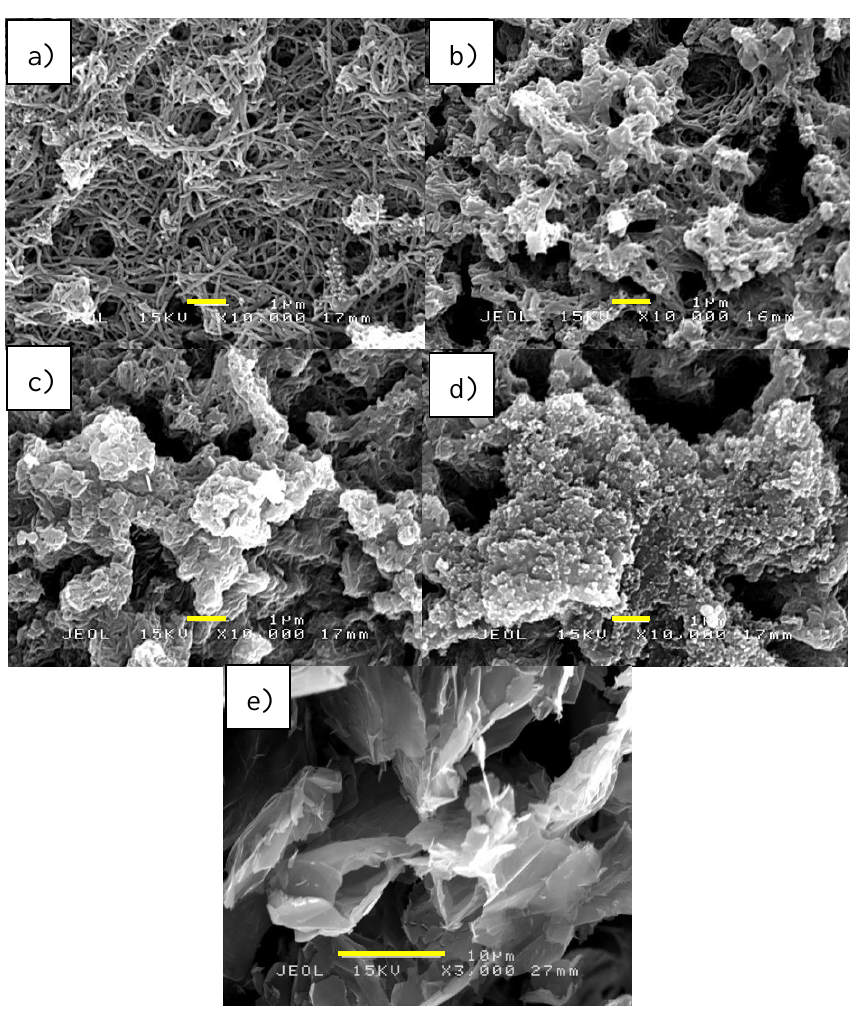
Figure 3. SEM images of PANI/GP nanofibers at different wt % of GP to aniline ( a ) 5 wt %; ( b ) 10 wt %; ( c ) 25 wt %; ( d ) 50 wt % and ( e ) graphene.